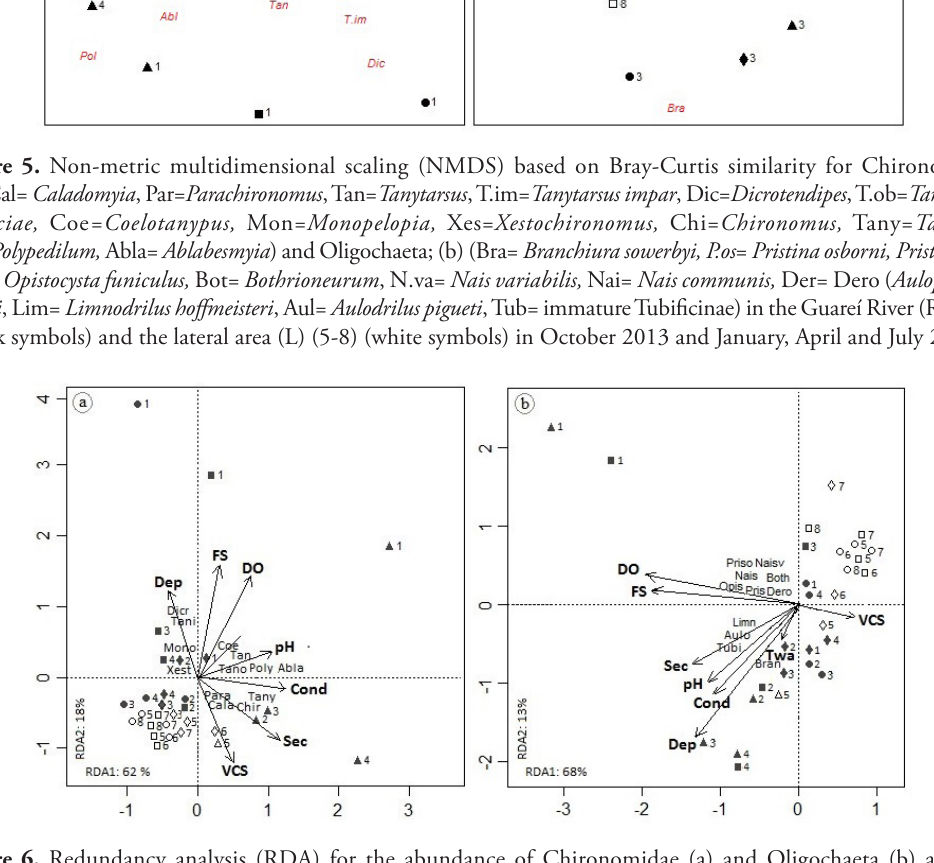
Figure 6. Redundancy analysis (RDA) for the abundance of Chironomidae (a) and Oligochaeta (b) and the environmental variables in the Guareí River (black symbols) (1-4) and lateral area (white symbols) (5-8) during the study period (see symbol key in Figure